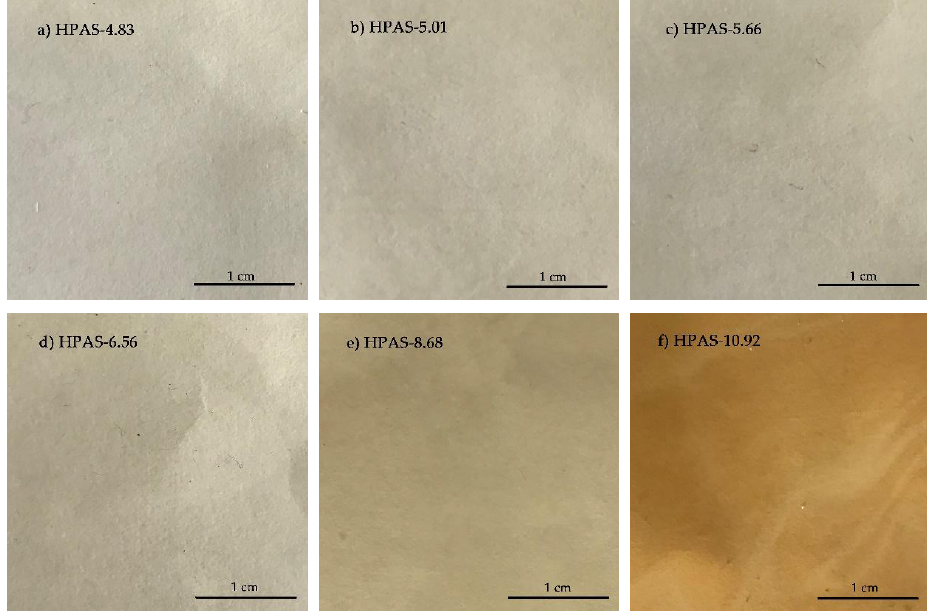
Figure 1. Images of HPAS-CA films with different citric acid amount.